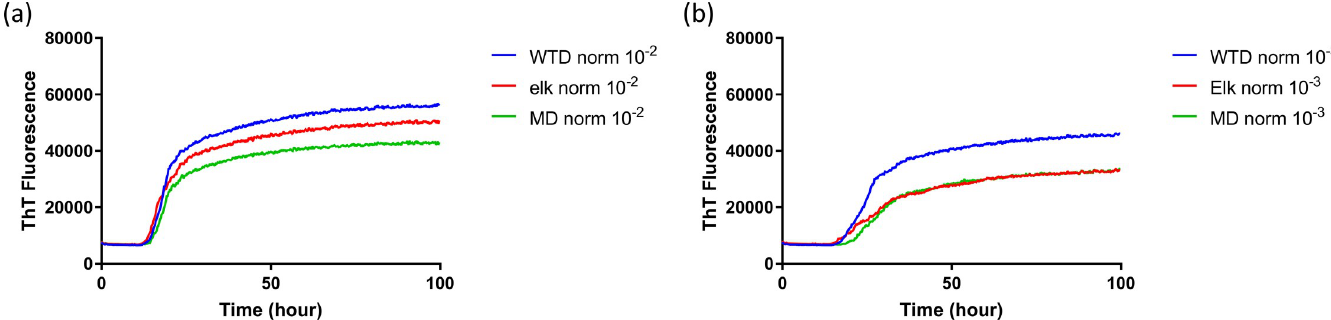
Fig 8. Comparison of averaged seeding activity of RT-QuIC reactions with BV rPrP seeded with brains from reindeer inoculated with brains of infectious cervid species. (WTD: blue line, elk: red line, MD: green line). All assays seeded with (a) 10 − 2 or (b) 10 − 3 dilution of EIA normalized stock dilutions of reindeer brains inoculated with each CWD source was averaged and compared to assays seeded with two other CWD inocula. Data are presented as mean ThT fluorescence of 4 repeated reactions.